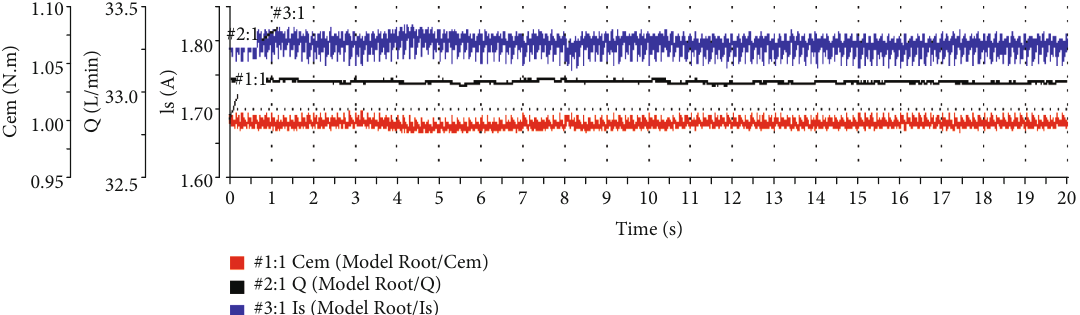
Figure 21: Steady-state pump characteristics.